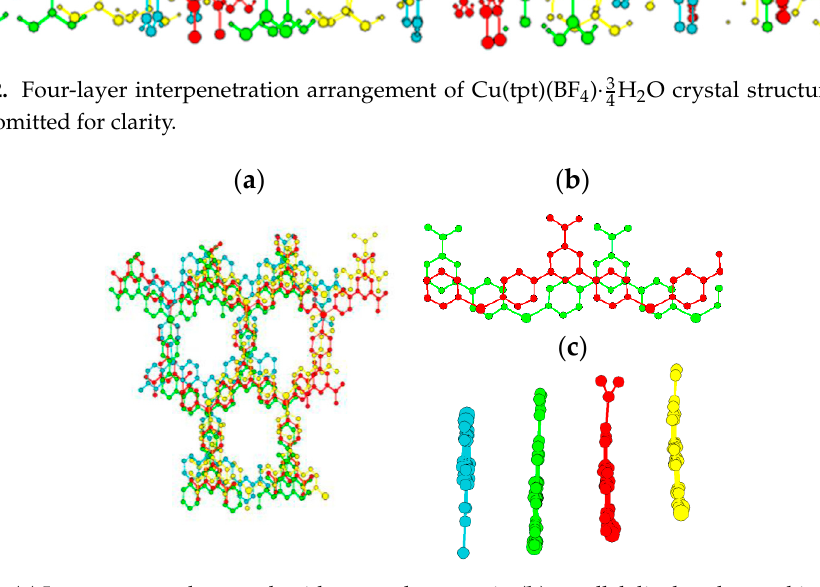
Figure 3. ( a ) Interpenetrated network with pores along a-axis; ( b ) parallel displaced π -stacking between interpenetrating layers, with π -stacking distances of 3.2 Å ( c ) side view of displacement. Guest species and hydrogen atoms omitted for clarity.